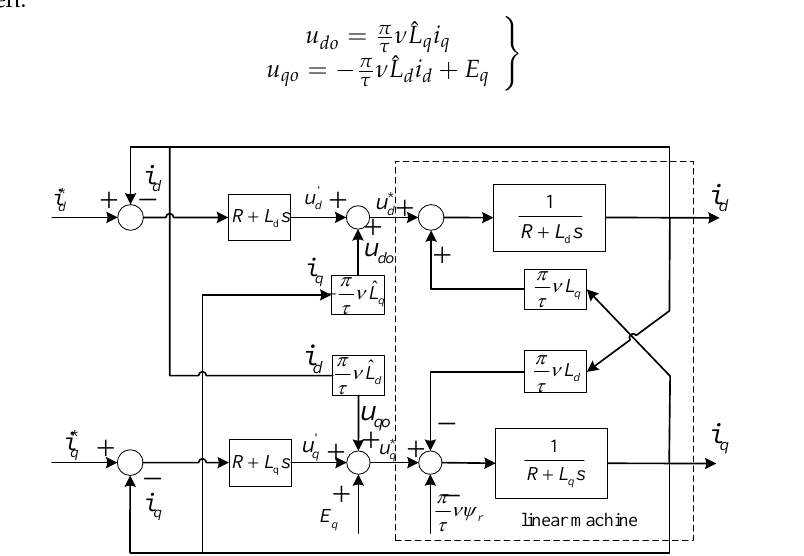
Figure 3. Control strategy based on decoupling of current feedback.